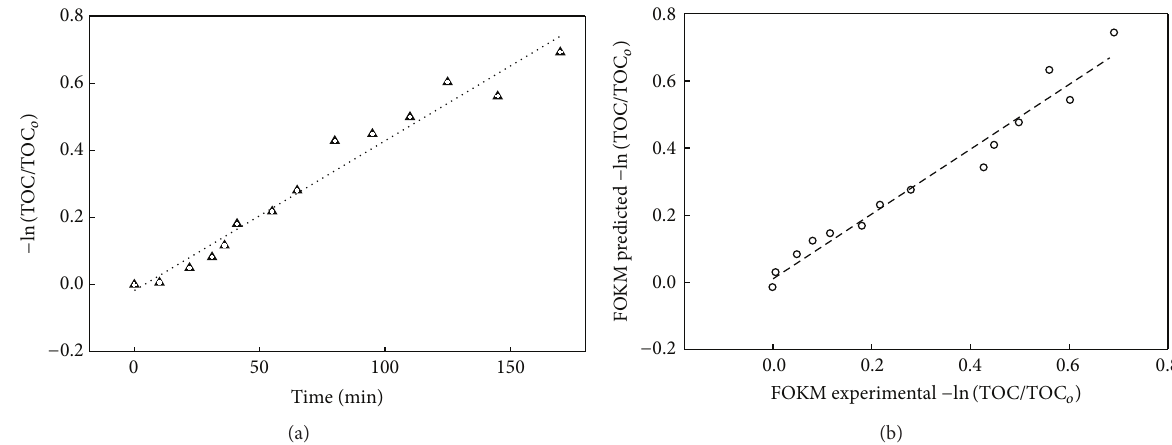
Figure 1: Plots for FKM (a) kinetic and (b) predicted versus experimental.